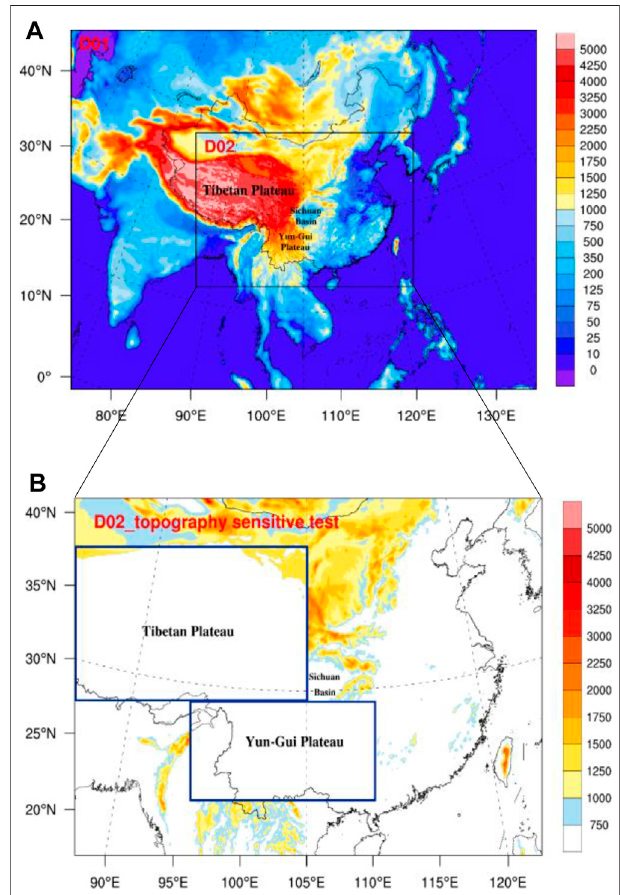
FIGURE 1 | (A) Two domains (D01 – D02) used in the Weather Research and Forecasting (WRF) simulations and (B) the modi fi ed topography (m, shaded) for D02 in the NOTER experiment. The Tibetan Plateau, Yungui Plateau, and Sichuan Basin are marked. Two blue boxes indicate the areas of the NOTER